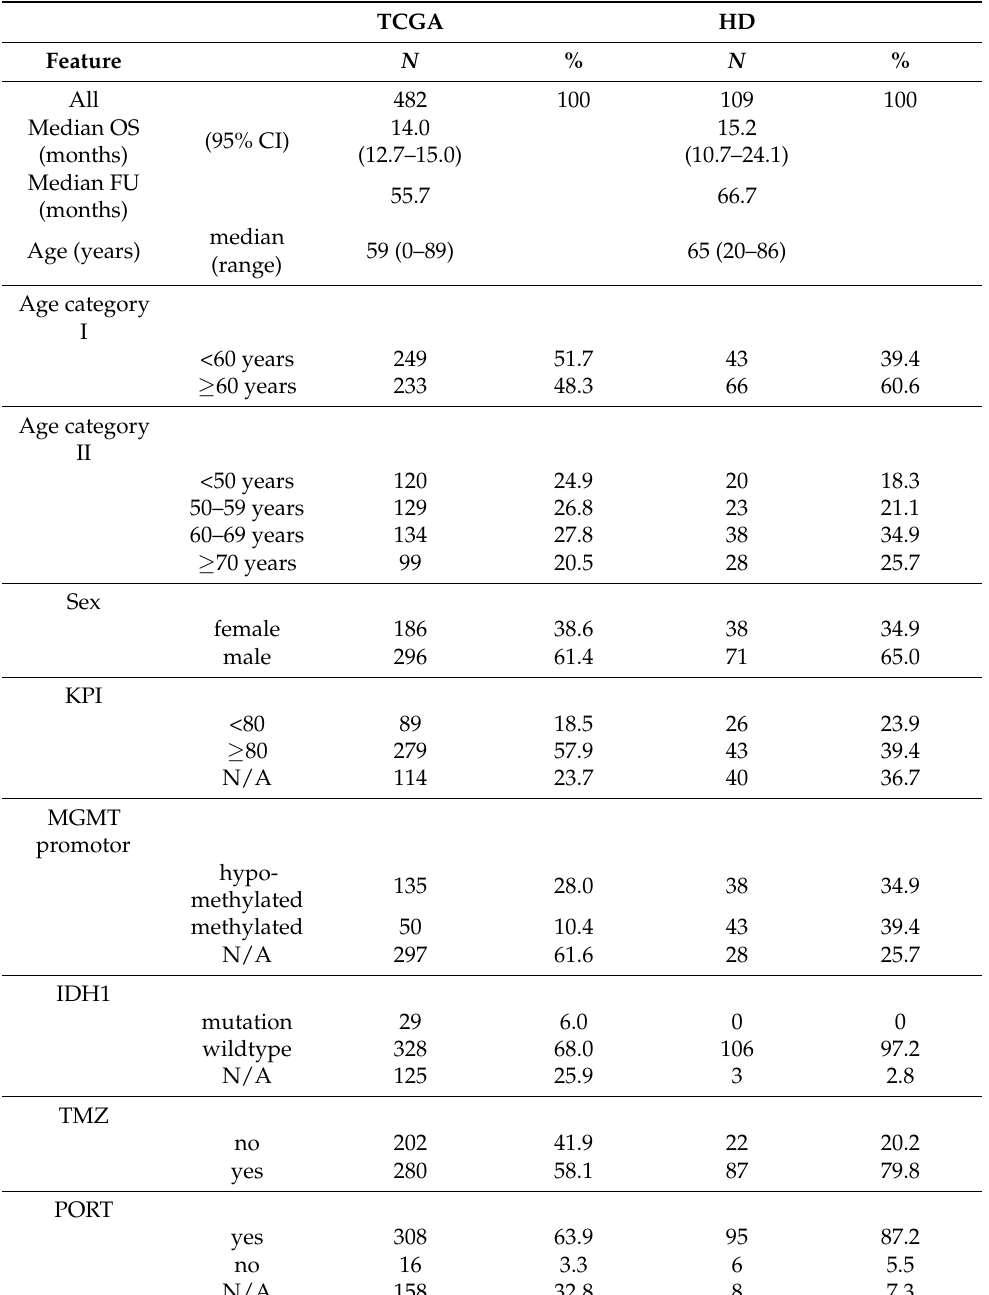
Table 1. Patients’ characteristics of The Cancer Genome Atlas (TCGA) and Heidelberg University Hospital (HD) cohort. OS: overall survival; FU: follow-up period; KPI: Karnofsky performance index; MGMT: O-6-methylguanine-DNA methyltransferase; TMZ: temozolomide; PORT: postoperative